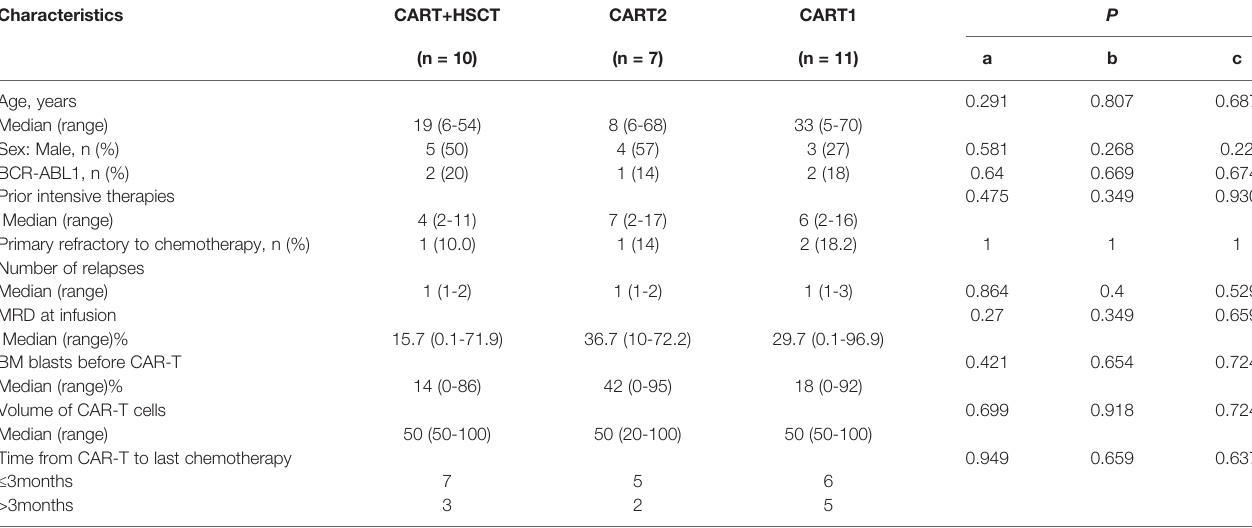
TABLE 1 | Patient